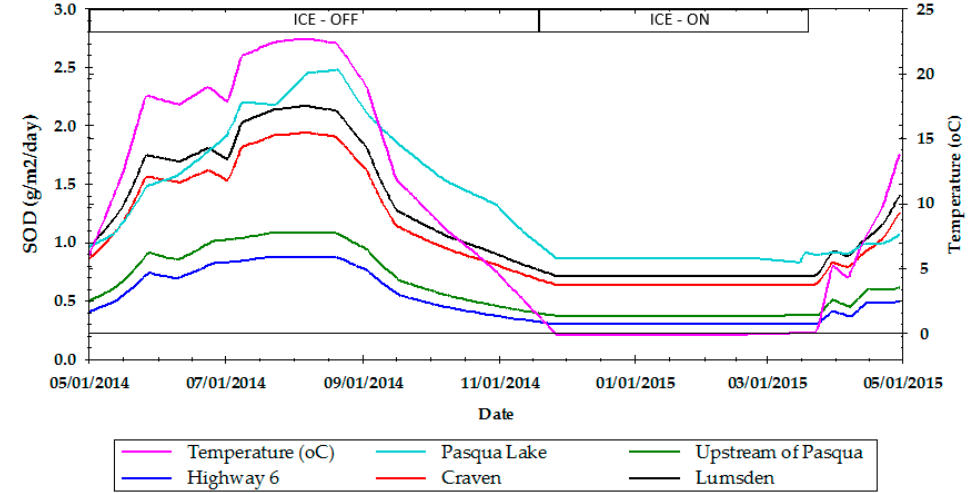
Figure 6. Seasonal variation of SOD rate in the QR system (these rates are model-based results and not normalized to 20 °C).